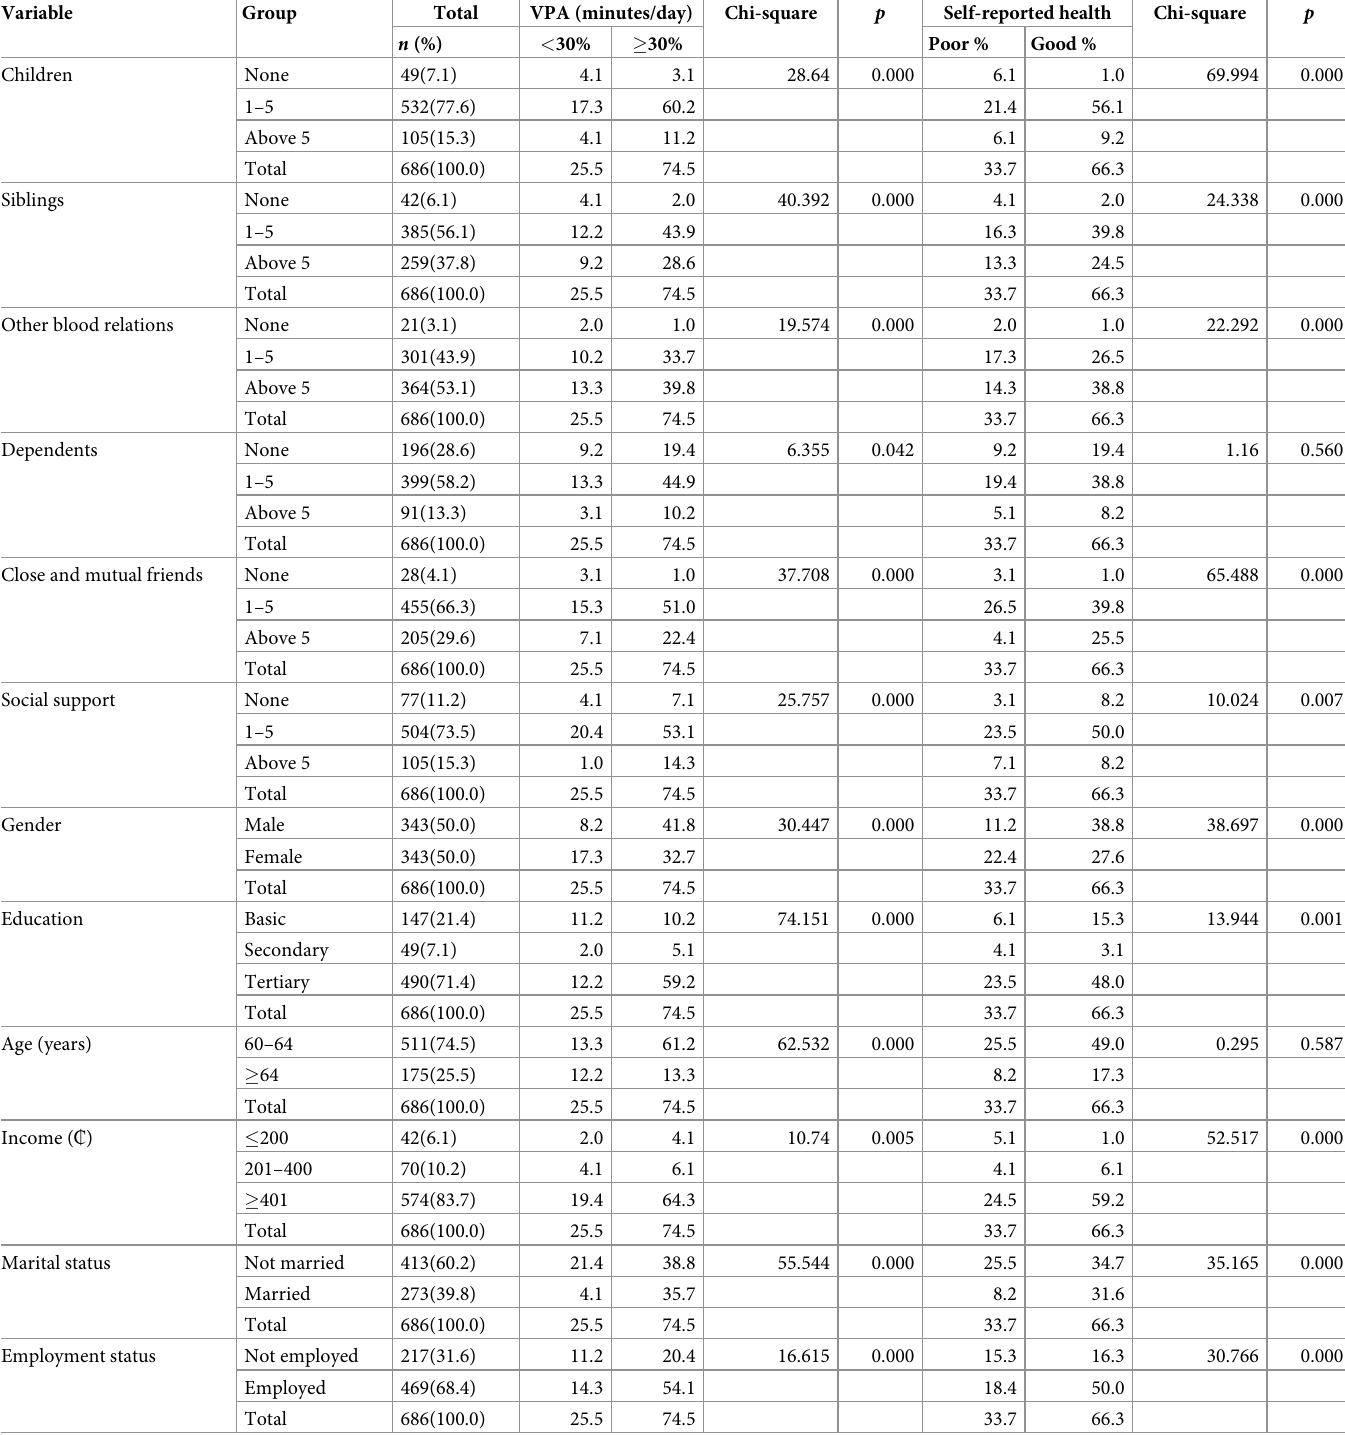
Table 1. Group differences by VPA and self-reported health.